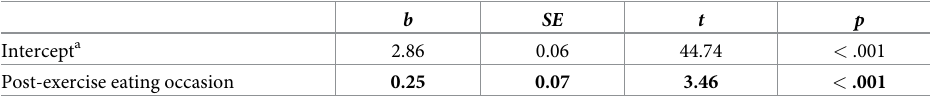
Table 6. Exercise as a predictor of self-reported portion size of meals (Study 2). b SE t p Intercept a 2.86 44.74 < .001 Post-exercise eating occasion 0.25 3.46 < .001